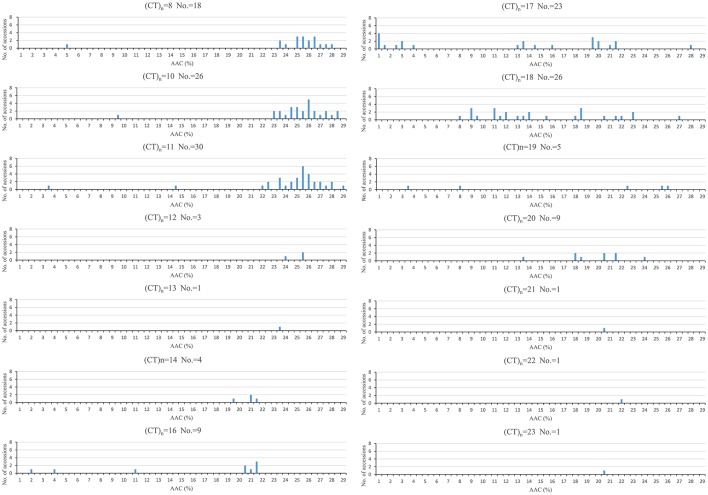
AAC distribution in association with Waxy (CT)n alleles of RM190. No, number of accessions in each group.